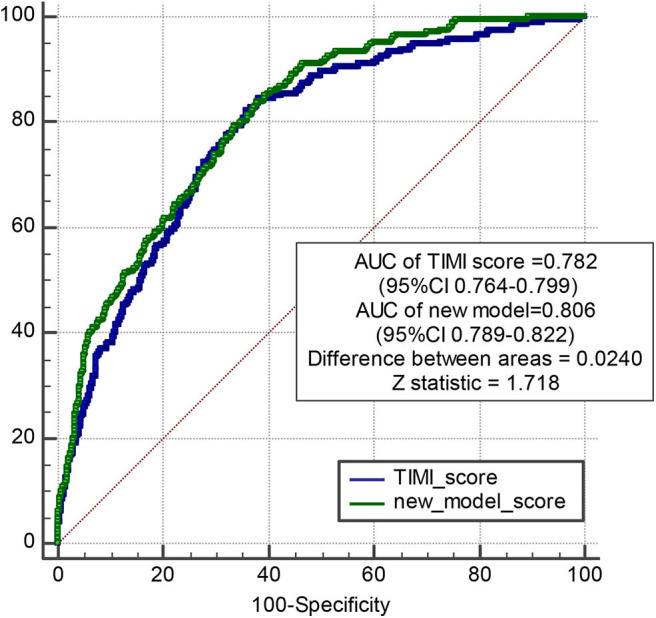
Pairwise comparison of ROC curves between new model and TIMI risk score model. The AUC of new model is 0.806, and the AUC of TIMI score is 0.782. Difference between areas = 0.0240 < 0.05; z statistic, 1.718.